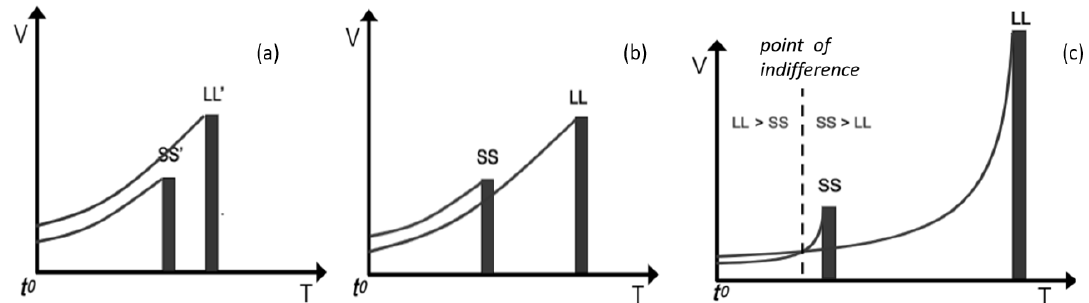
Figure 1: Images (a) and (b) describe temporally consistent preferences; image (c) shows temporally inconsistent